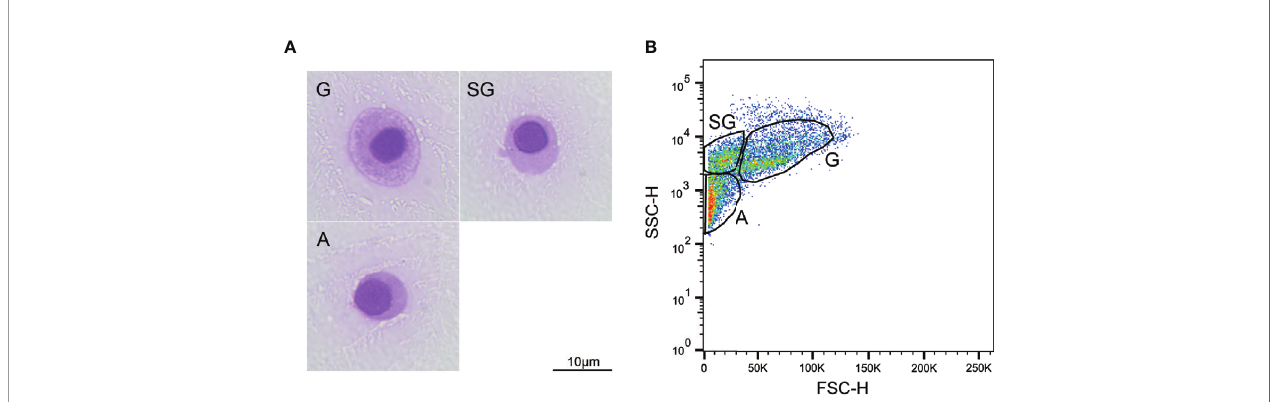
FIGURE 1 | Morphological characterization of C. hongkongensis hemocytes. (A) Light micrographs of different hemocyte subpopulations after Wright-Giemsa staining. (B) Flow cytometric dot plot of size (FSC) against internal complexity (SSC) of hemocyte subpopulations of a representative sample. G, granulocytes; SG, semi-granulocytes; A, agranulocytes.